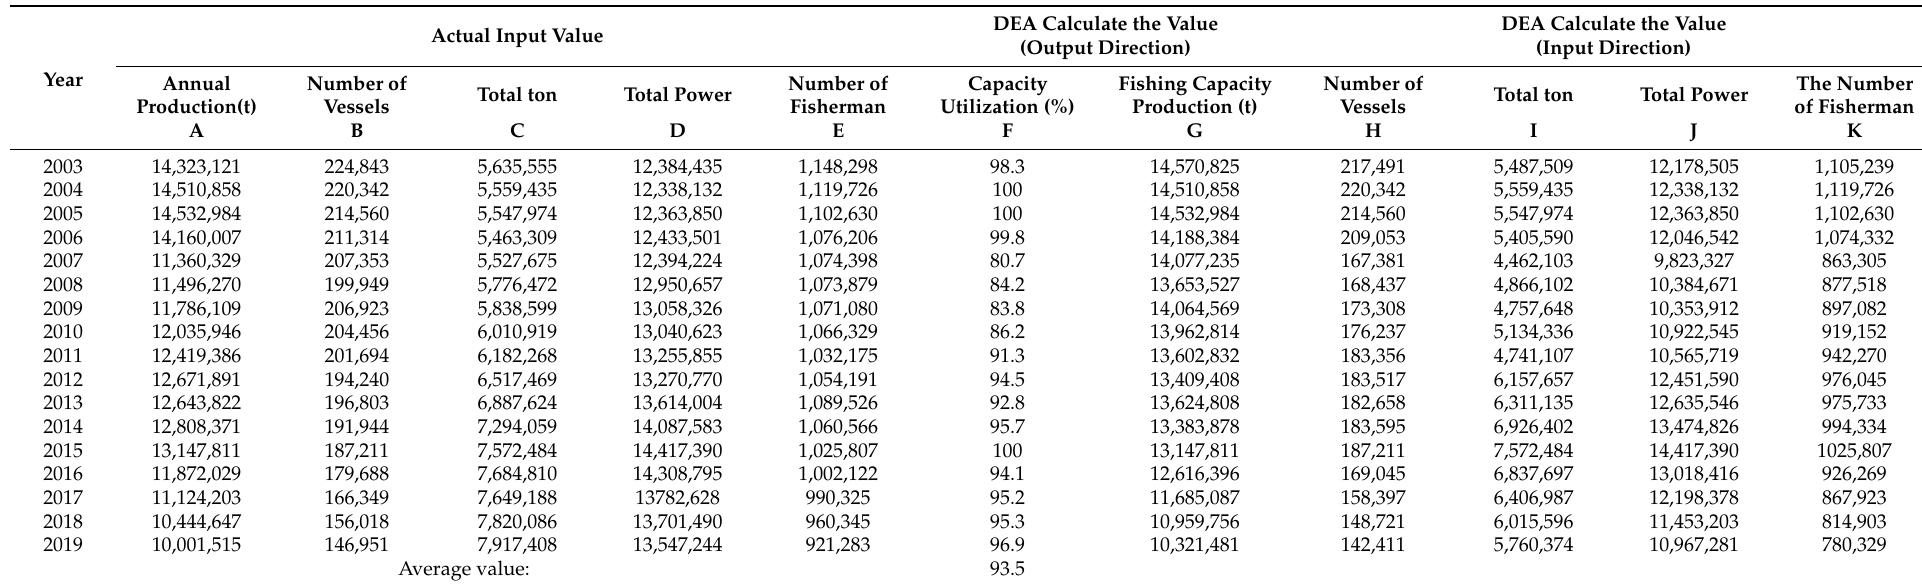
Table 3. Calculation of fishing capacity in China from 2003 to